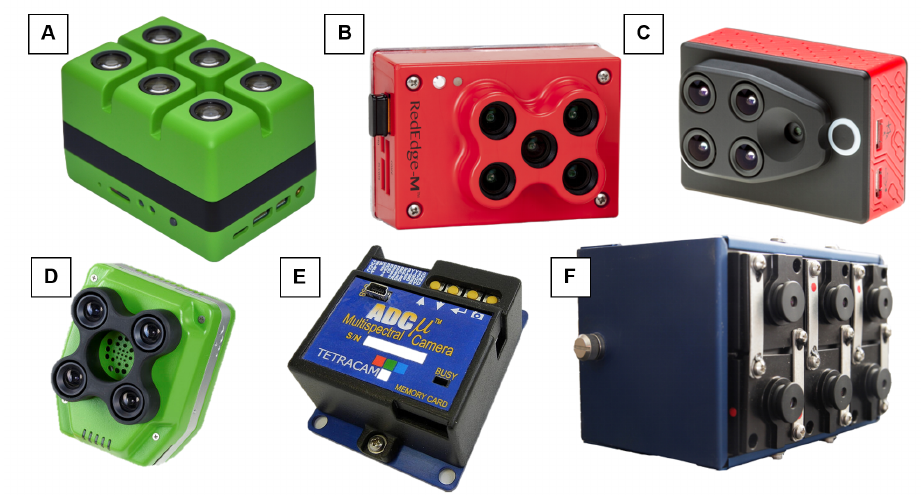
Figure 8. Some commonly used UAS multispectral cameras: ( A ) Buzzard Camera six; ( B ) MicaSense